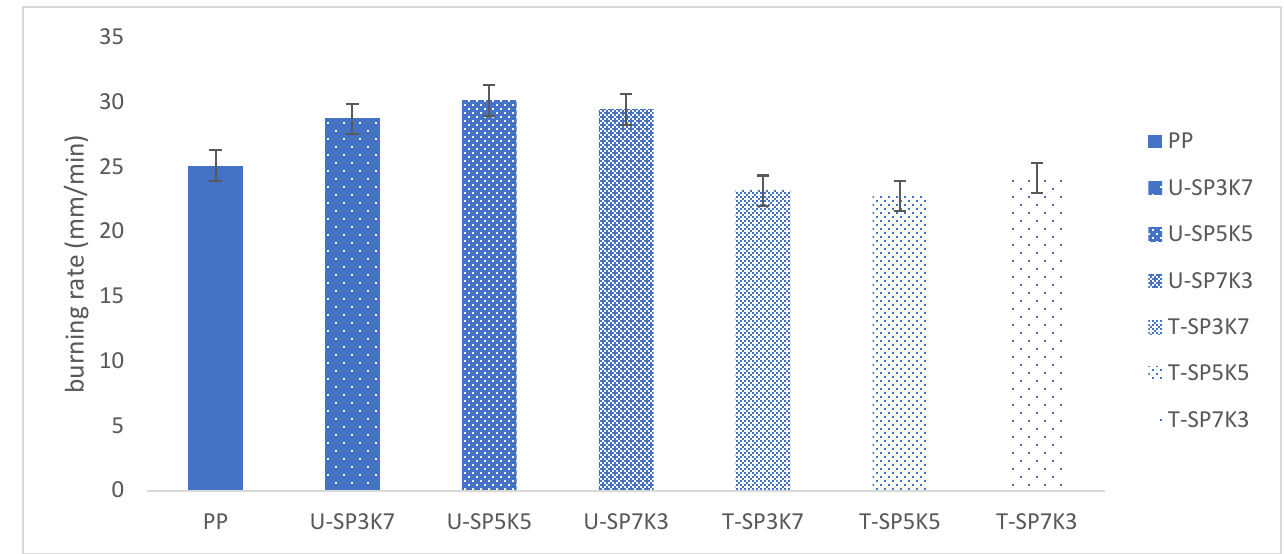
Figure 4. The effect of different fiber loadings on the burning rate of (SP/K/SP) hybrid composites.